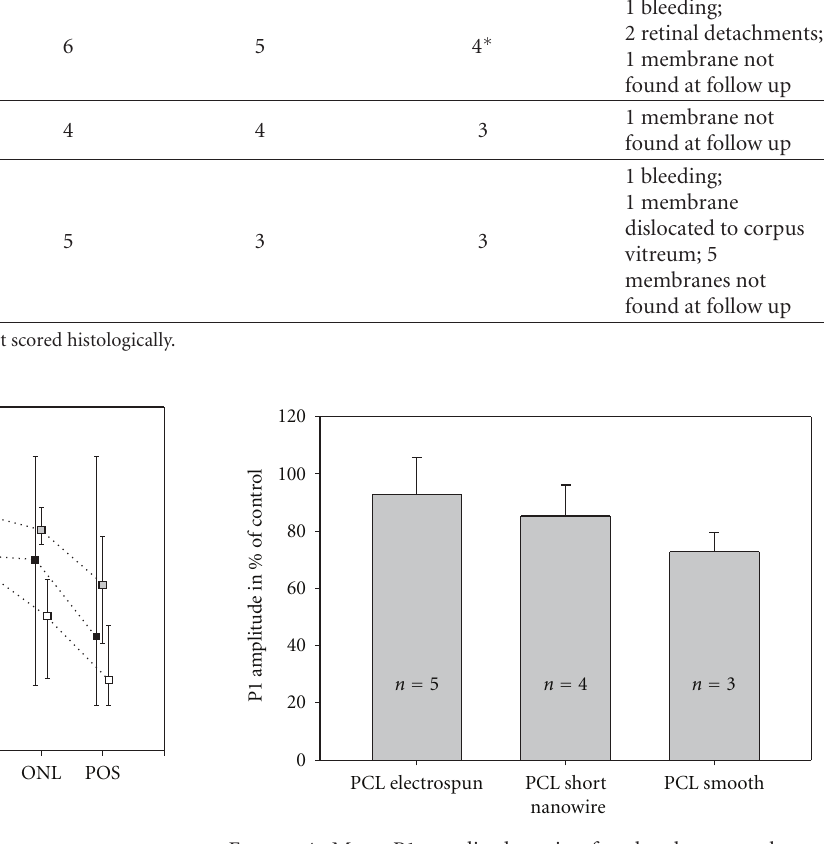
Figure 4: Mean P1 amplitude ratios for the three membrane- types. Ratios are given as the percentage of P1 amplitude for the membrane supported area of retina in the left eye compared to that of the corresponding area in the right untouched eye. Confidence intervals are given by the thin bars. Number of included animals for each membrane are written on the broad bars. No significant di ff erences are seen. Only the P1 amplitude ratio of PCL Smooth is significantly di ff erent from 1 ( P = 0 .